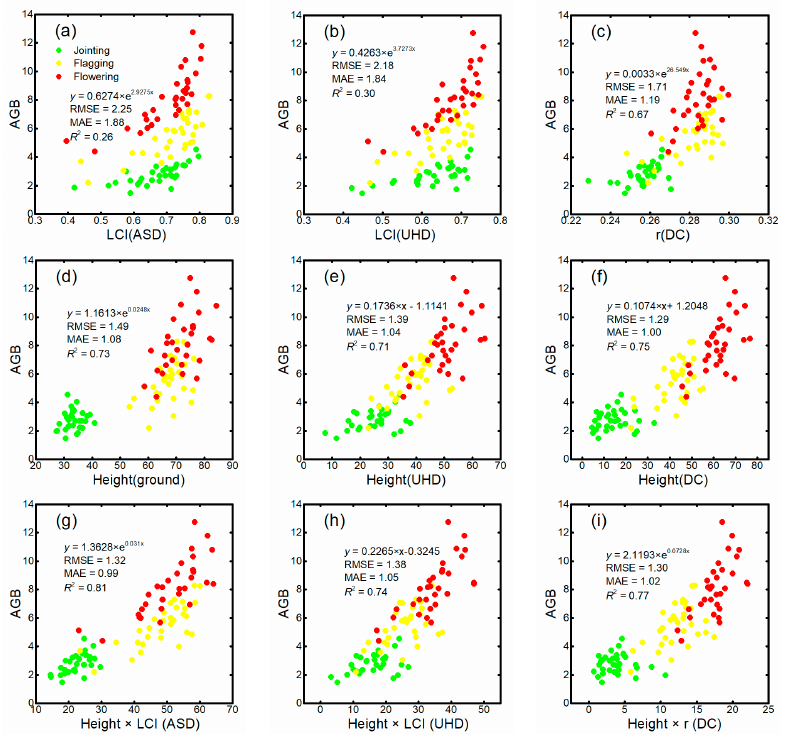
Figure 6. Relationship between best VIs and AGB: ( a ) G-LCI; ( b ) UHD-LCI; ( c ) DC-r; ( d ) G-height; ( e ) UHD-height; ( f ) DC-height; ( g ) G-height × LCI; ( h ) UHD-height × LCI; ( i ) DC-height × r.